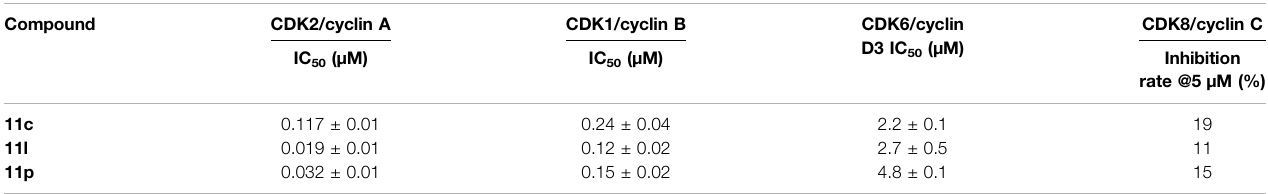
TABLE 2 | Inhibitory activity of selected compounds against different